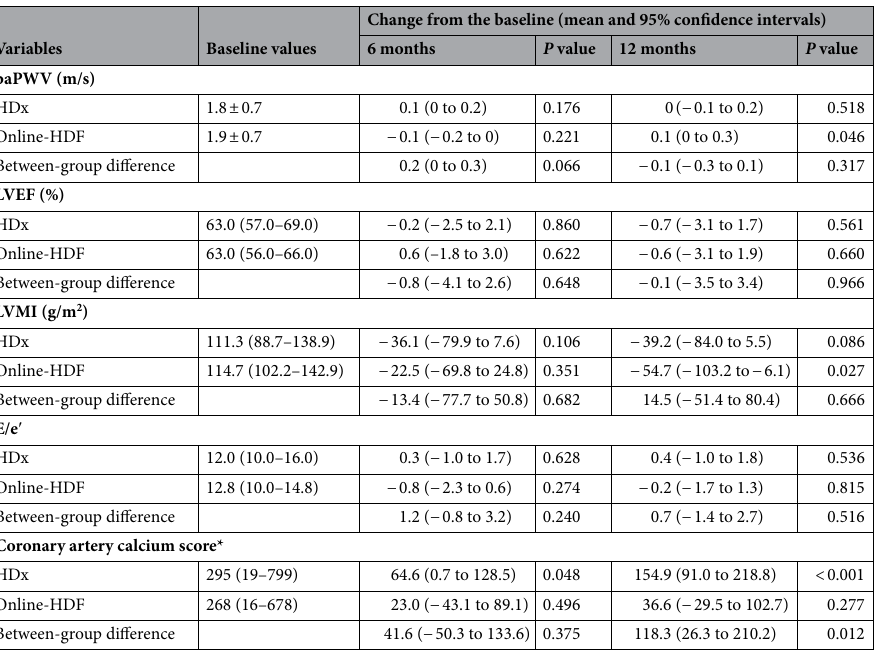
Table 2. Linear mixed-effects model for the change in cardiovascular biomarkers. baPWV brachial-ankle pulse wave velocity, HDx expanded hemodialysis, HDF hemodiafiltration, LVEF left ventricular ejection fraction, LVMI left ventricular mass index, E peak early mitral inflow velocity, e ′ peak early diastolic mitral annular velocity. *Available for 41 of the HDx group patients and 35 of the online-HDF group patients.